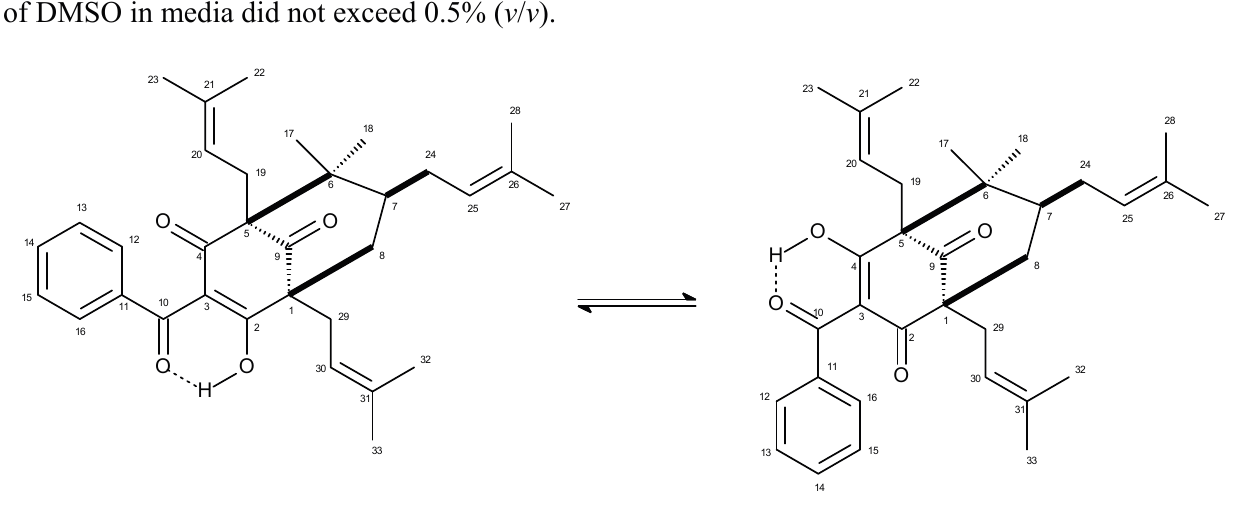
Figure 5. Tautomeric forms of